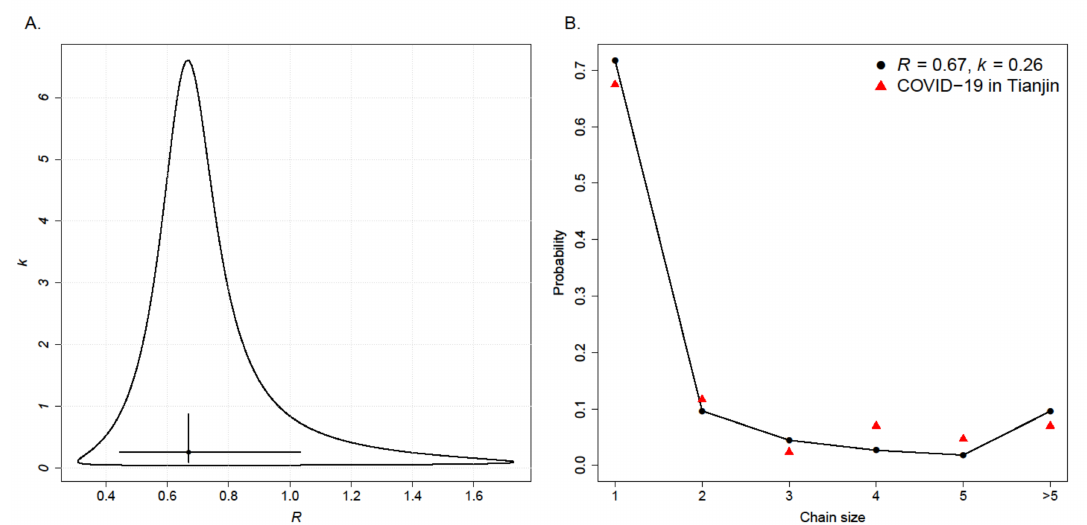
Figure 3. Analysis of COVID-19 outbreak in Tianjin using the combinatorial method. ( A ) The circle, cross hair, and curve represent the estimates, 95% confidence intervals, and confidence region of parameters R and k , respectively. ( B ) Circles denote the probability of a transmission chain with size from 1 to > 5 based on the estimates of R and k ; Triangle denotes the frequency of a transmission chain with corresponding size in Tianjin COVID-19